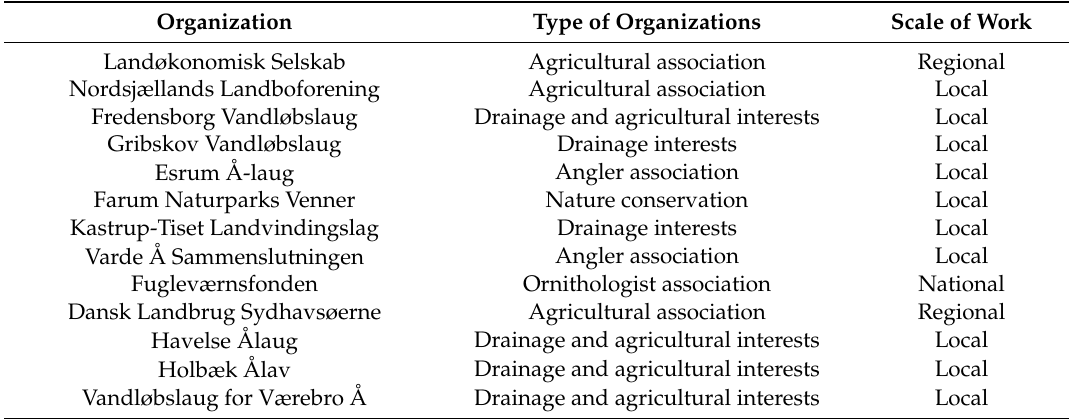
Table A1. List of participating organizations and